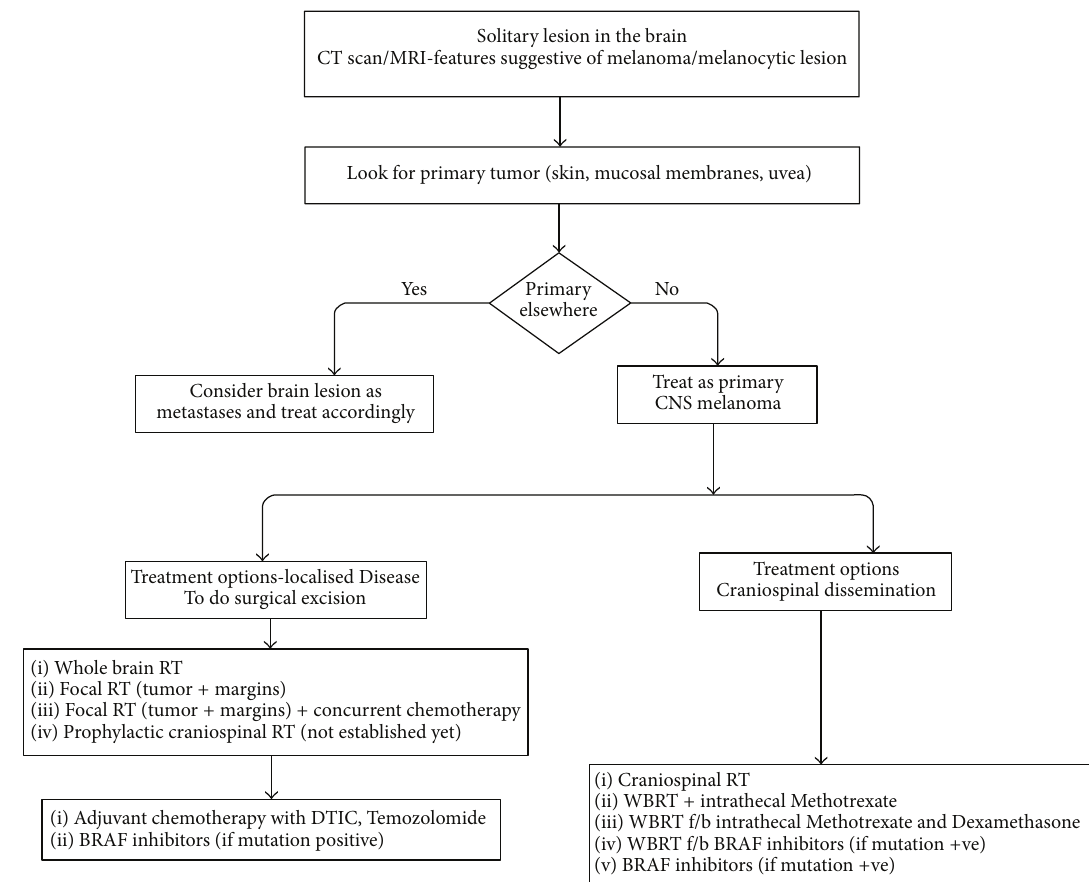
Figure 8: Proposed diagnostic/treatment algorithm for primary CNS